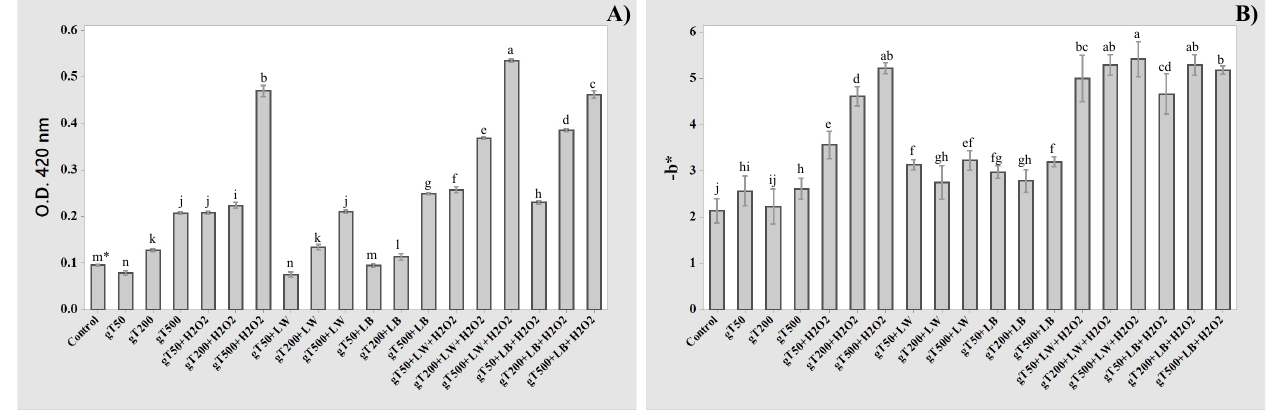
Figure 6. Effect of grape tannins’ (gT) addition at different concentration (50, 200, and 500 mg/L), light exposure (LW, LB), and hydrogen peroxide addition (H 2 O 2 ) on optical densities at 420 nm ( A ) and b* parameter ( B ).